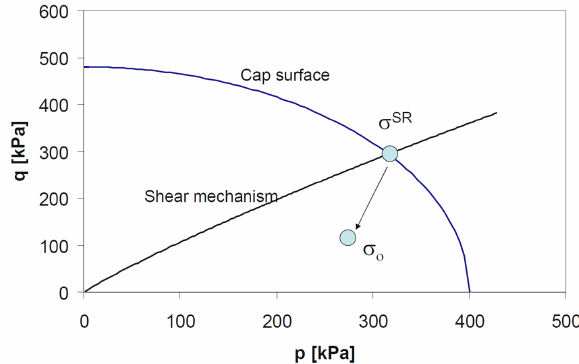
Figure 3: Setting the initial position of the plastic surfaces of the HS